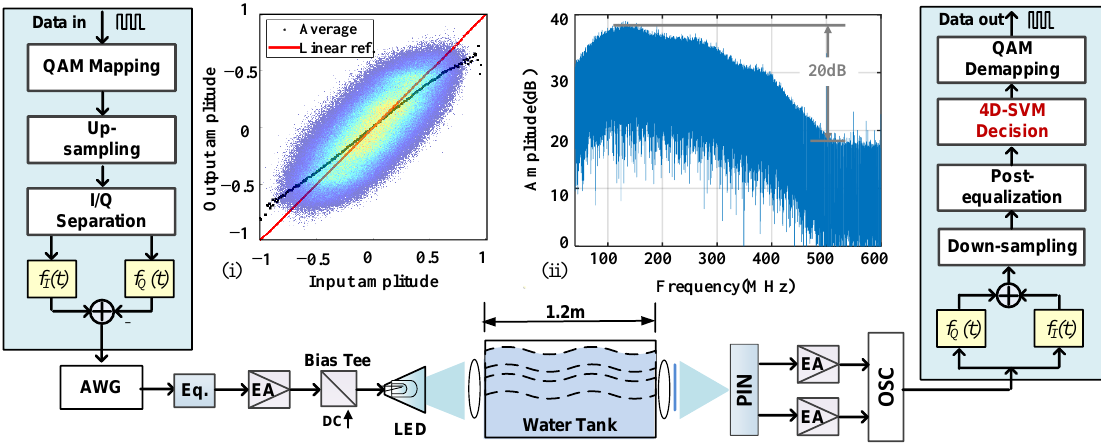
Figure 3. Experimental setup of the underwater visible light communication system. The inset (i) shows the normalized input amplitude – output amplitude (AM – AM) of the UVLC system at 1.1V and 1.6 Gbps. The red line is the linear reference. The black points are the average value in a small grid of input amplitude. Obviously, the AM – AM